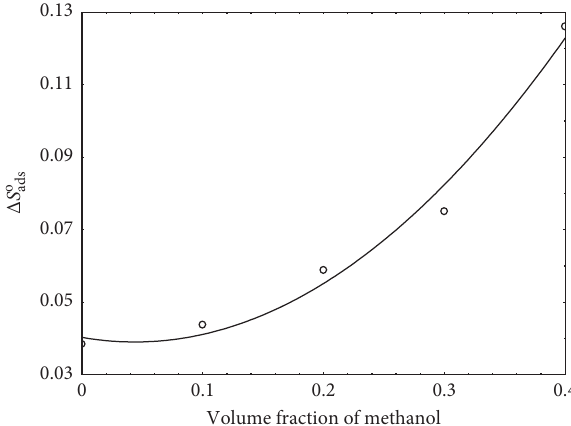
Figure 7: Variation in Δ S o